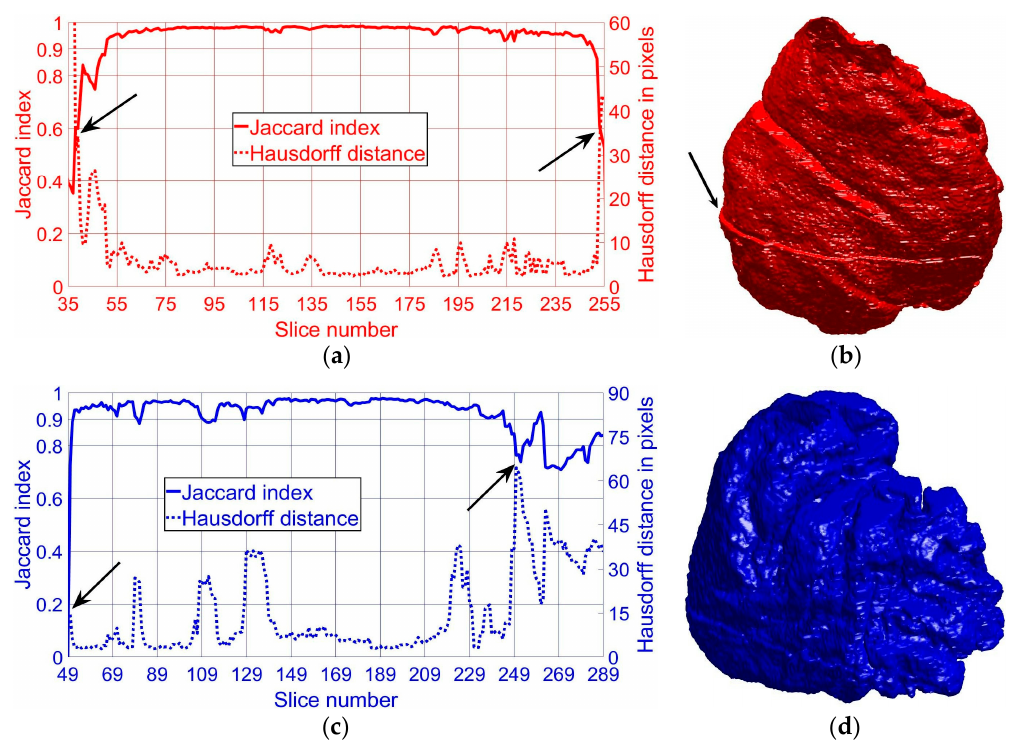
Figure 3. Illustration of the propagation regions. Regions of a slice that overlap with the regions of a previous segmentation are maintained, whilst regions that do not are discarded. The algorithm propagates up and down, starting from central slice (slice number 150 for all seven cells which were segmented in this work), in the same way as a human expert to include or discard regions.